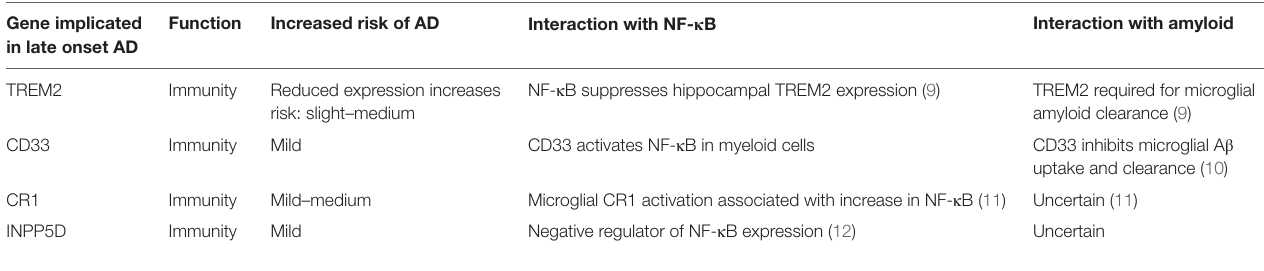
TABle 1 | Emerging genetic risk factors for Alzheimer’s disease (AD) and their associated with nuclear factor-kappa B (NF- κ B) and amyloid (8). Gene implicated Function increased risk of AD interaction with nF- κ B interaction with amyloid in late onset AD TREM2